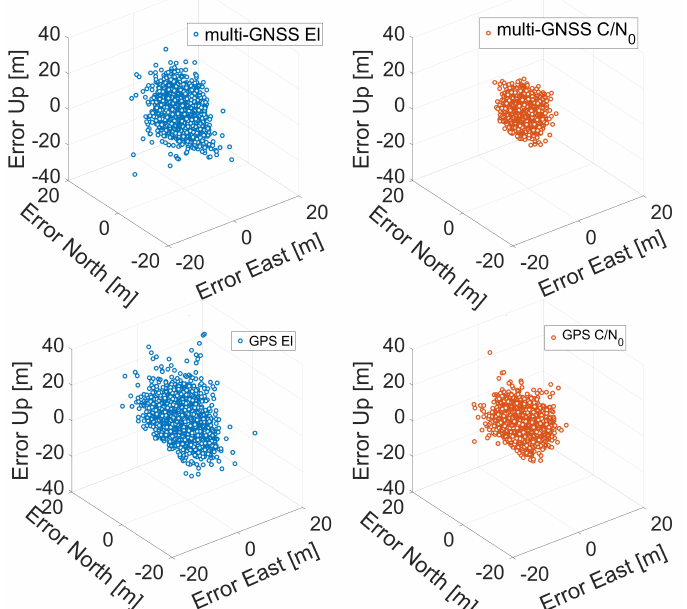
Figure 9. Three-dimensional coordinate error scatter plots for single point positioning of Huawei P30. The first row corresponds to the multi-GNSS solution while the second row to the GPS one. Blue markers represent errors when the solution was obtained using elevation-dependent weights; red circles represent errors obtained using C / N 0